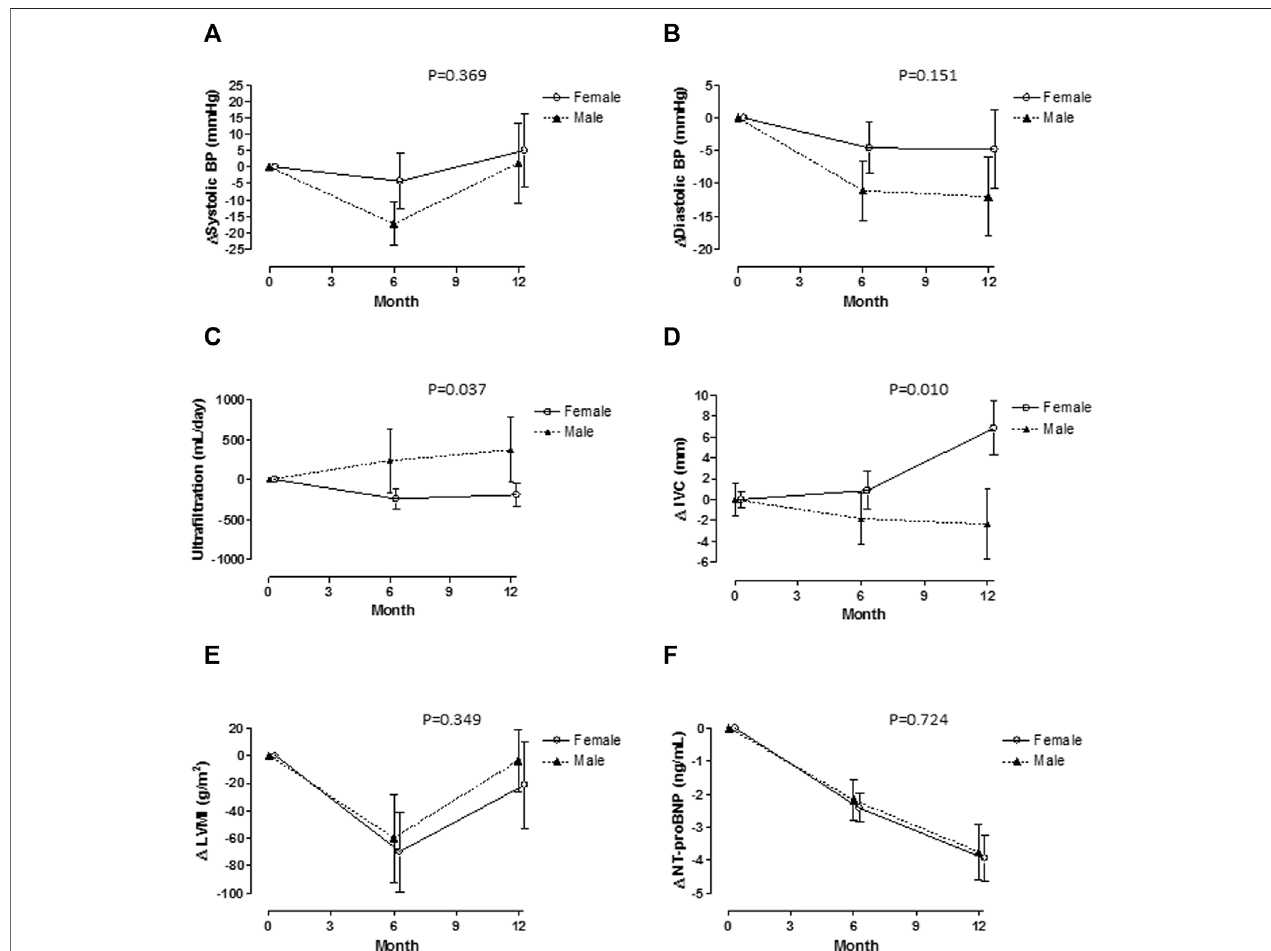
FIGURE 2 | Cardiovascular variables are shown by sex. Systolic blood pressure (A) decreased at six months, but move back to baseline values there were no differences by sex. Diastolic blood pressure decreased after six months with a more signi fi cant change in females (B) . Changes in ultra fi ltration were different, in males increasedandinfemaleshadsmalldecrements (C) .InferiorVenaCavavariedinoppositeway,increasedinfemalesanddecreasedinmales (D) .Leftventriclemassindex and NT-proBNP changes are shown in (E,F) , there were no signi fi cant differences by